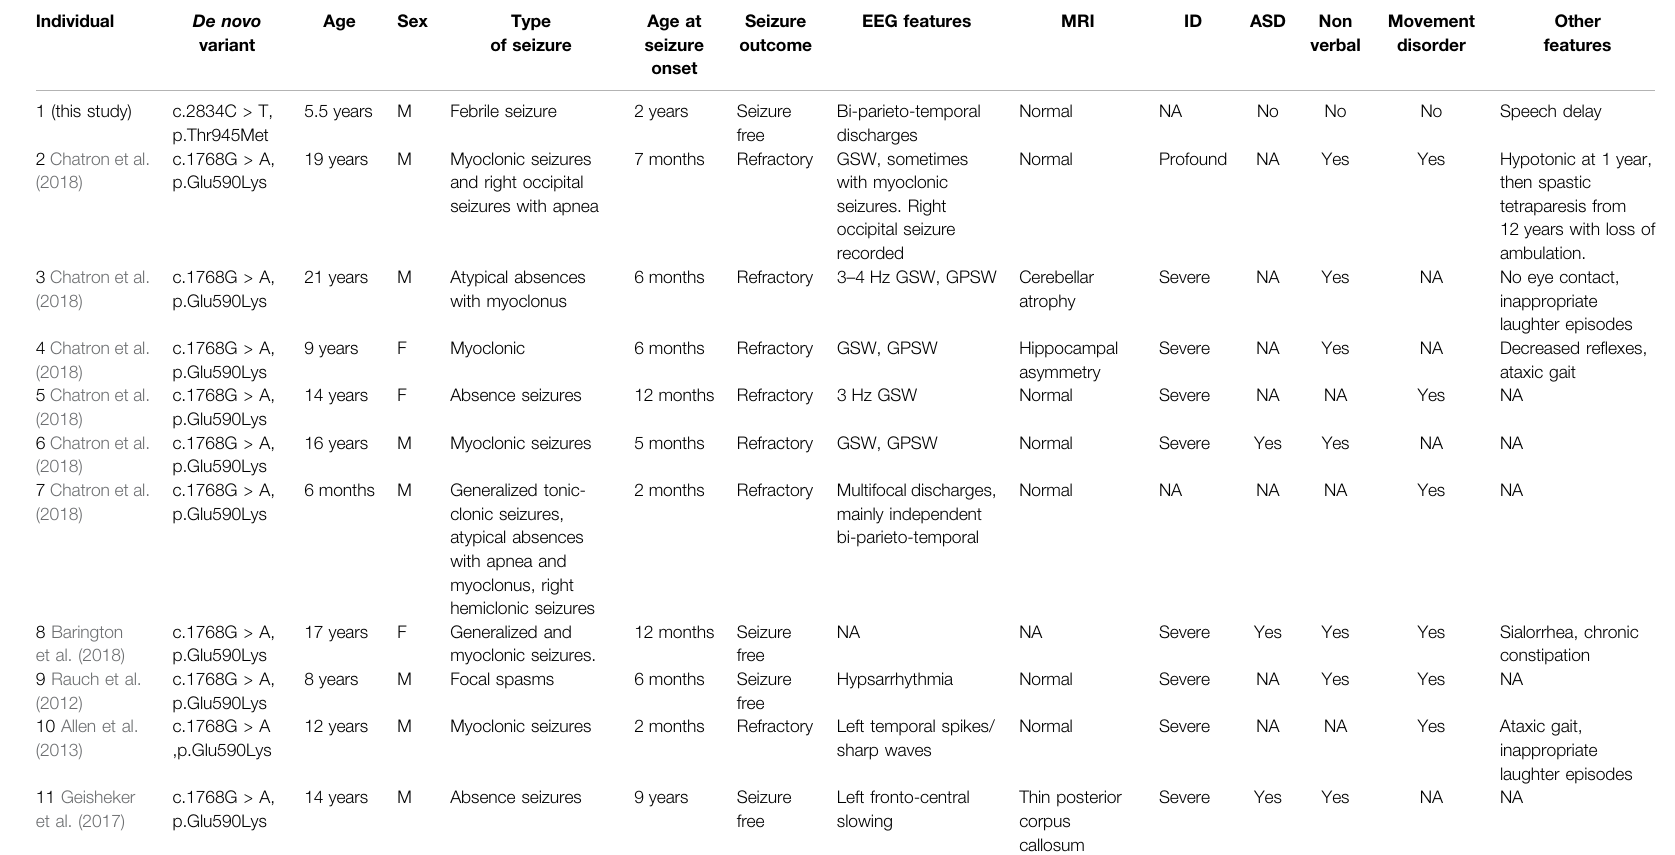
TABLE 1 | Clinical features of individuals with the CUX2